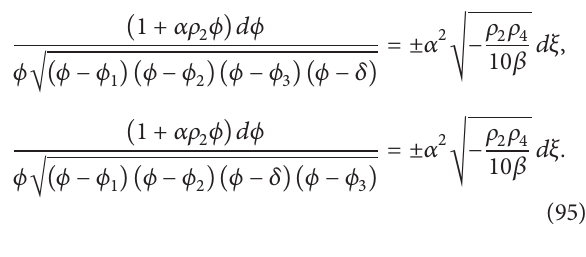
Respectively, substituting (93) and (94) into the equation 𝑑𝜙/𝑑𝜉 = 𝑦 of (13)